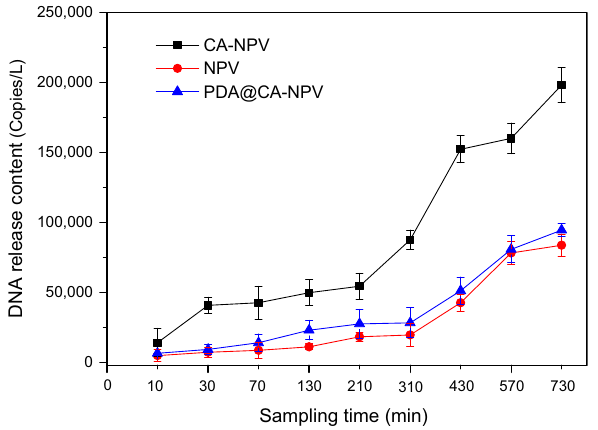
Figure 11. Release of genomics DNA from SeMNPV OBs and CA-NPV and PDA@CA-NPV encapsulated formulations at in sodium hydroxide solution. The standard curve was obtained by diluting the standard sample with 6 gradients: 10 8 , 10 7 , 10 6 , 10 5 , 10 4 , 10 3 , and taking the CT value as the horizontal coordinate and the concentration logarithm of dilution multiple as the vertical coordinate. Samples of the receiving buffer were withdrawn at different time intervals and the viral genome copies were quantified by qPCR. the DNA concentration of CA-NPV, SeMNPV, PDA@CA-NPV was 22,736 copies/L, 4897 copies/L, and 6519 copies/L, respectively, in NaOH (pH 10) for 10 min. CA-NPV and PDA@CA-NPV released the contained virus rapidly after 310 min. The slope of the release curve increased dramatically, and the release rate decreased gradually from 570 to 730 min.